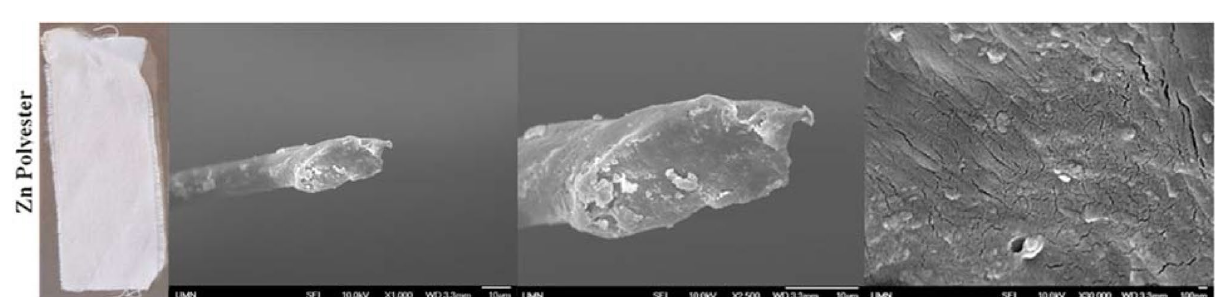
Figure 4. SEM images of nanoparticles harvested from zinc treated polyester